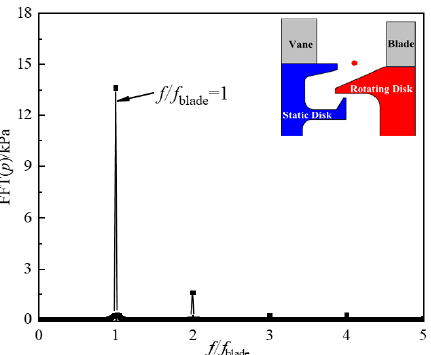
Figure 8. Pressure–frequency curve for the monitoring point at the clearance outlet (Seal-A and IF = 0.6%).